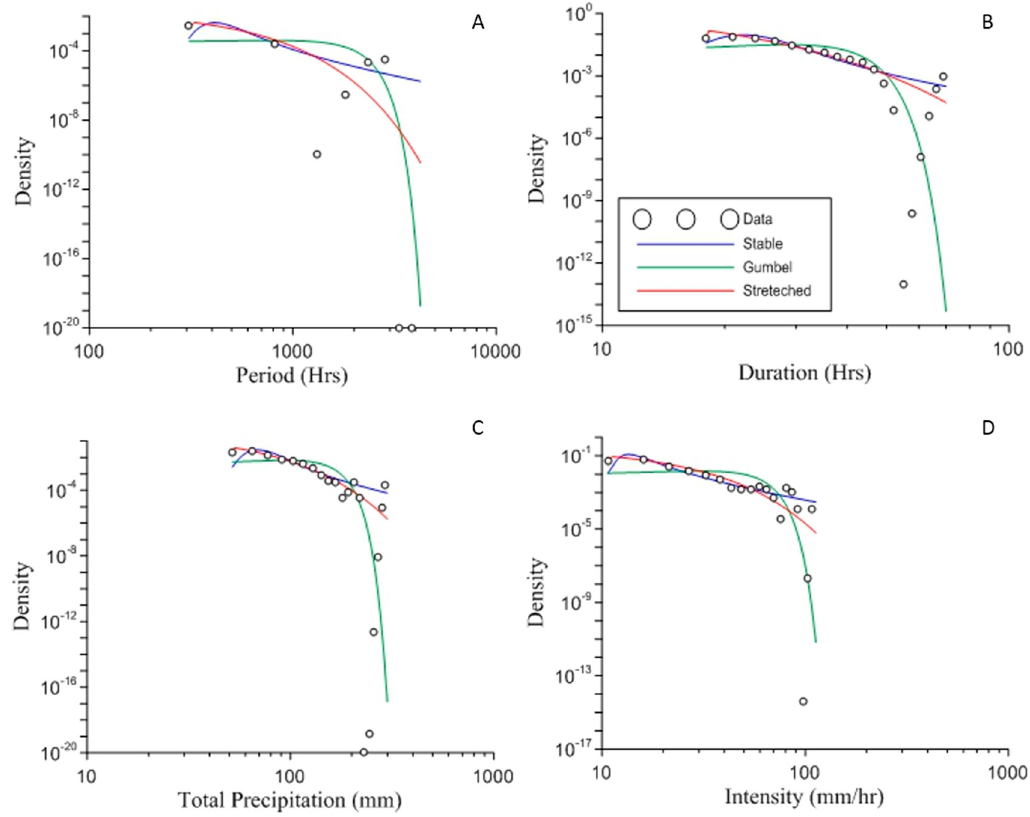
Figure 6. The best-fit PDF distribution for the extreme value set of each storm property: Inter-storm periods ( A ), duration ( B ), total precipitation ( C ), and intensity ( D ), using the three proposed distributions: Stable (the blue line), Gumbel (green line), and stretched Gaussian (red line) compared to the actual data (open circles).